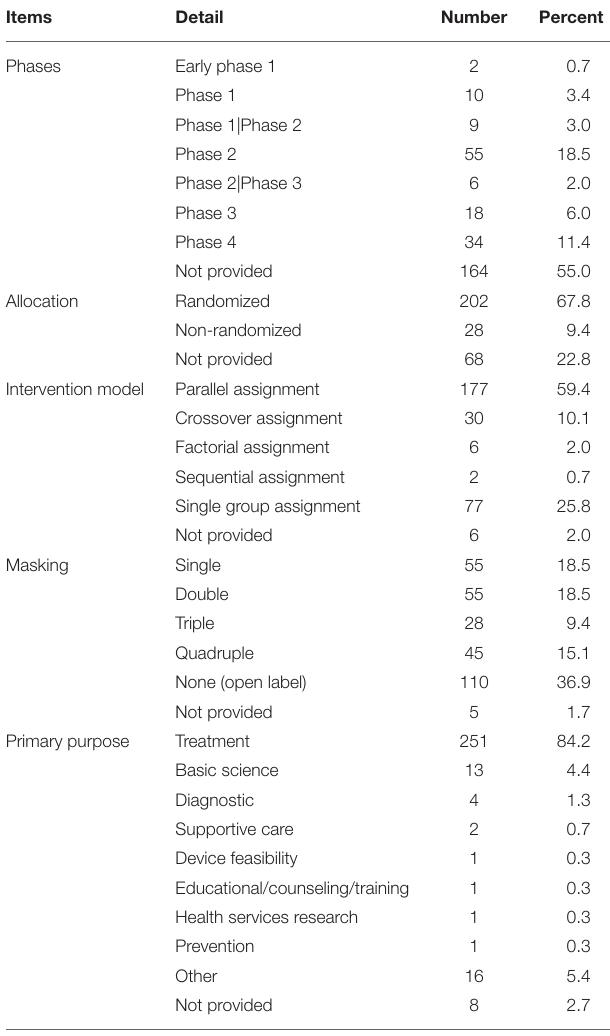
TABLE 2 | Design characteristic of OCD trials registered in ClinicalTrials.gov (n = 298).